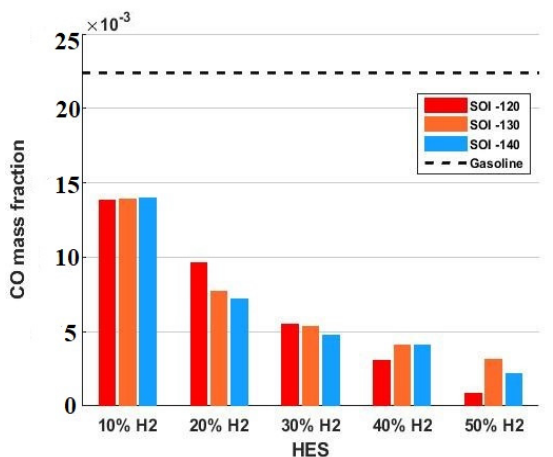
Figure 13. Effects of direct hydrogen injection timing and HES on the CO emissions.